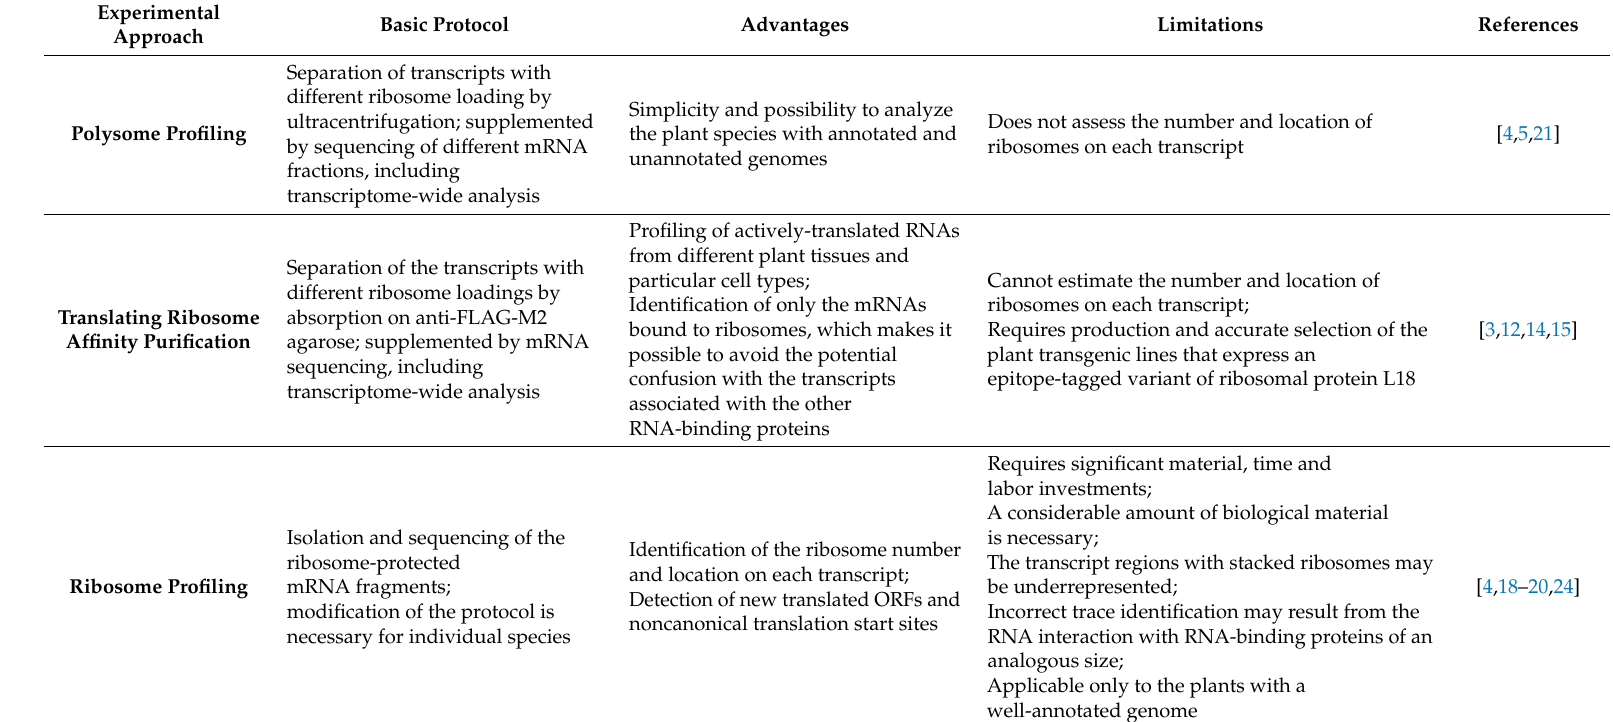
Table 1. Comparative characterization of the experimental approaches producing pools of differentially-translated